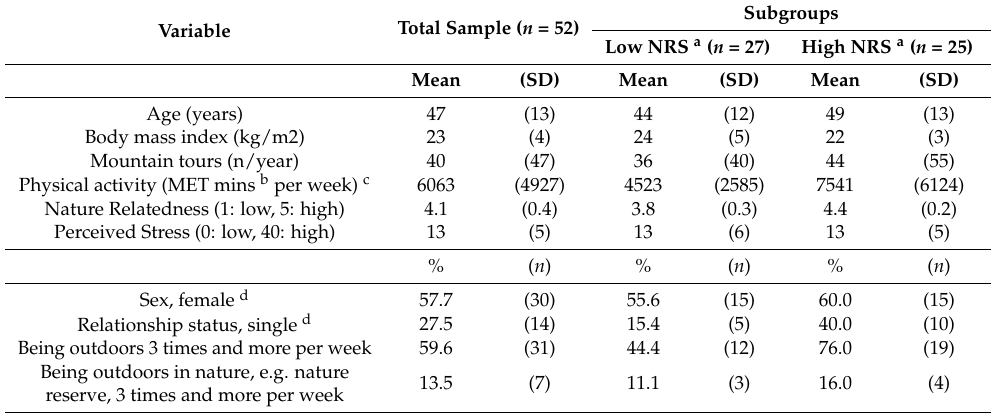
Table 1. Demographic data for the total sample and by subgroups with low and high nature